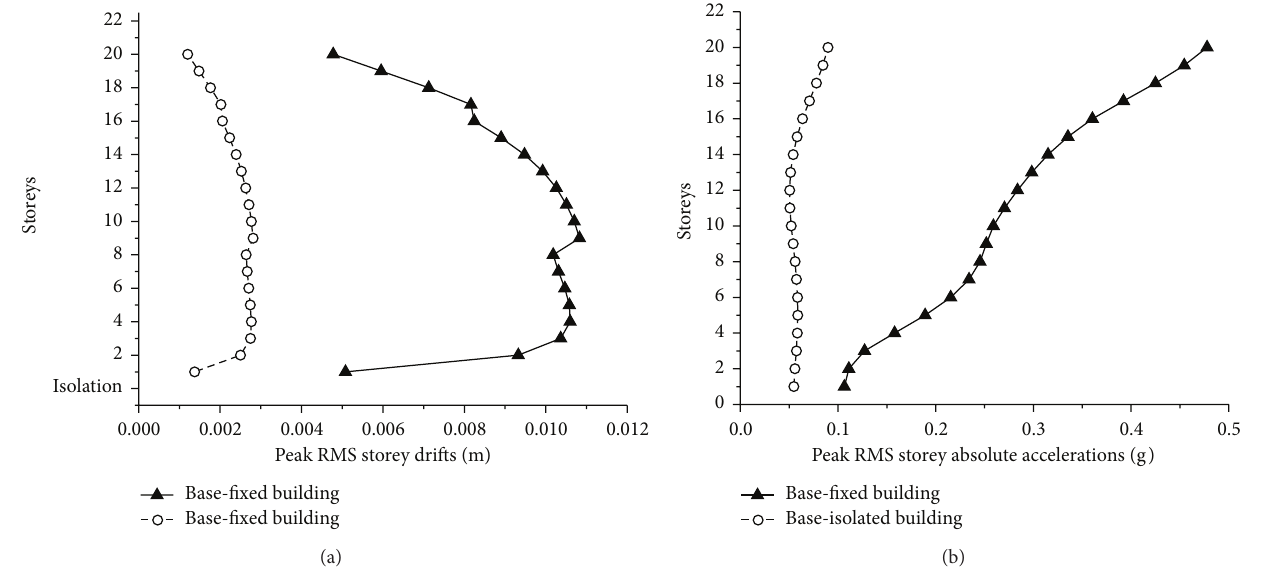
Figure 5: Comparison of (a) the peak RMS storey drifts and (b) the absolute storey accelerations of the base-fixed and base-isolated buildings.